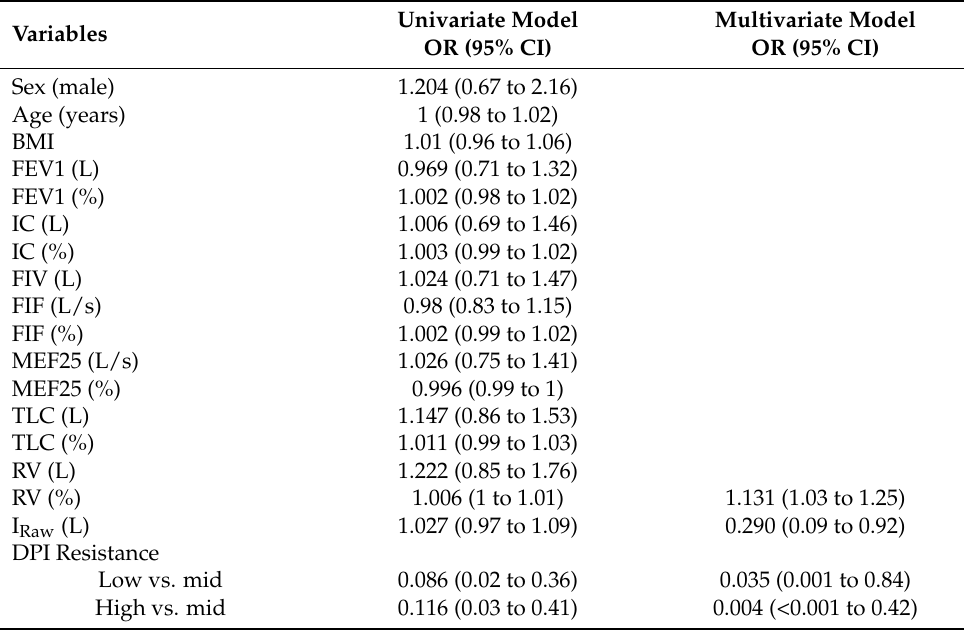
Table 3. Results of univariate and multivariate logistic regression (after stepwise selection).